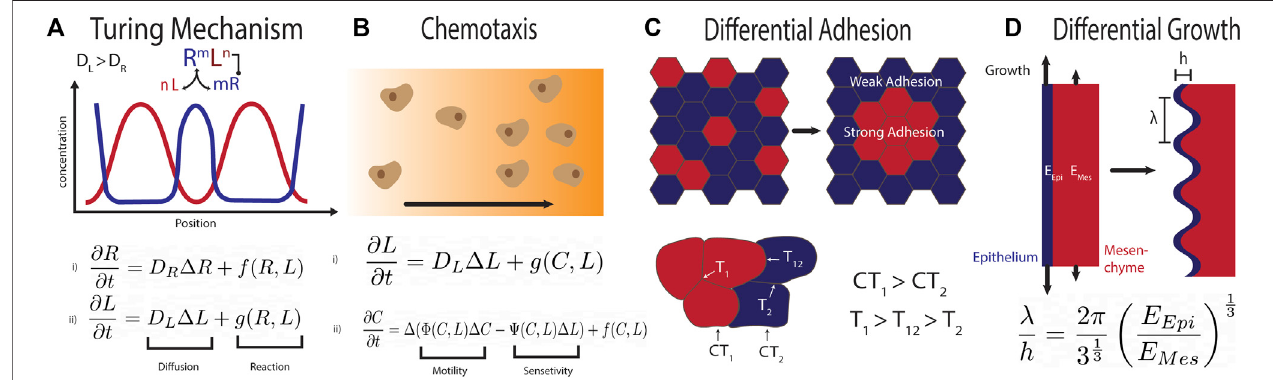
FIGURE2 |(A) Repetitive patterns canemerge viaa Turingmechanism when tworegulatoryfactors thatdiffuse at different speeds engagein anegativefeedback Turing (1952). In case of the ligand-receptor based Turing mechanism, the binding of the rapidly diffusing ligand (L) to the slowly diffusing receptor (R) results in up- regulationofthereceptorandremovaloftheligand.Thissystemcanbemodelledwithtwocoupledpartialdifferentialreactiondiffusionequations.Thissystemcanyielda large variety of patterns, dependent on the reaction parameters and the tissue geometry. (B) Chemotaxis can result in periodic patterning when motile cells (C) produce and consume the diffusible chemoattractant or chemorepellent ( L ), as modelled for instance by the Keller-Segel model Keller and Segel (1971). (C) Differential adhesion between the blue and the red cells can result in periodic pattern formation. The mixture of cells is dependent on their relative surface tension (CT 1 for the red, CT 2 for the blue population). This results in three different relative surface tensions (T 1 between red cells, T 2 between blue and T 12 between the two populations) Canty